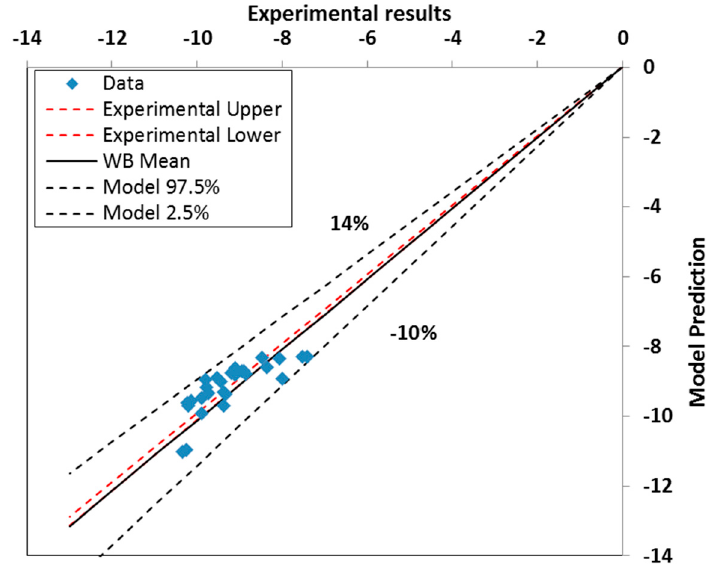
Figure 10. Comparison of AE model prediction and experimental results (log da / dN ). WB indicates Bayesian regression analysis results using WinBugs.